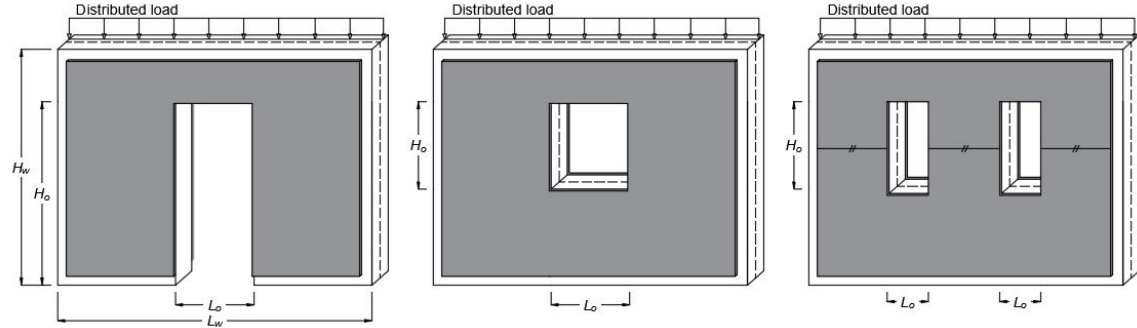
Figure 9. Geometry of the wall models with various opening types and configurations.